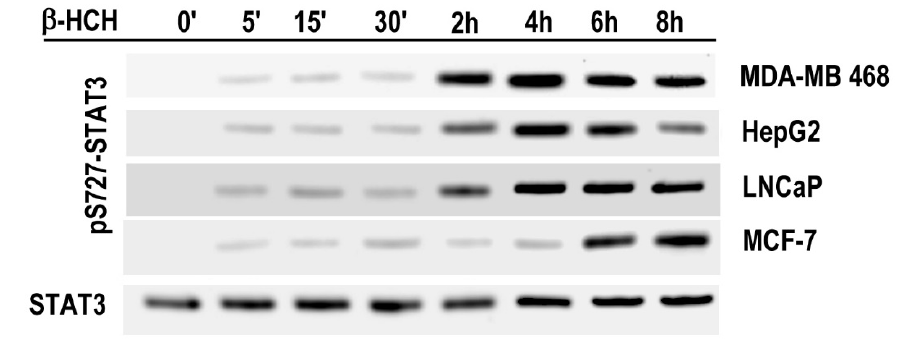
Figure 4. Immunoblot analysis of pS727-STAT3 in MDA-MB 468, HepG2, LNCaP, and MCF-7 cells after incubation with 10 μ M β‐ HCH at different times.